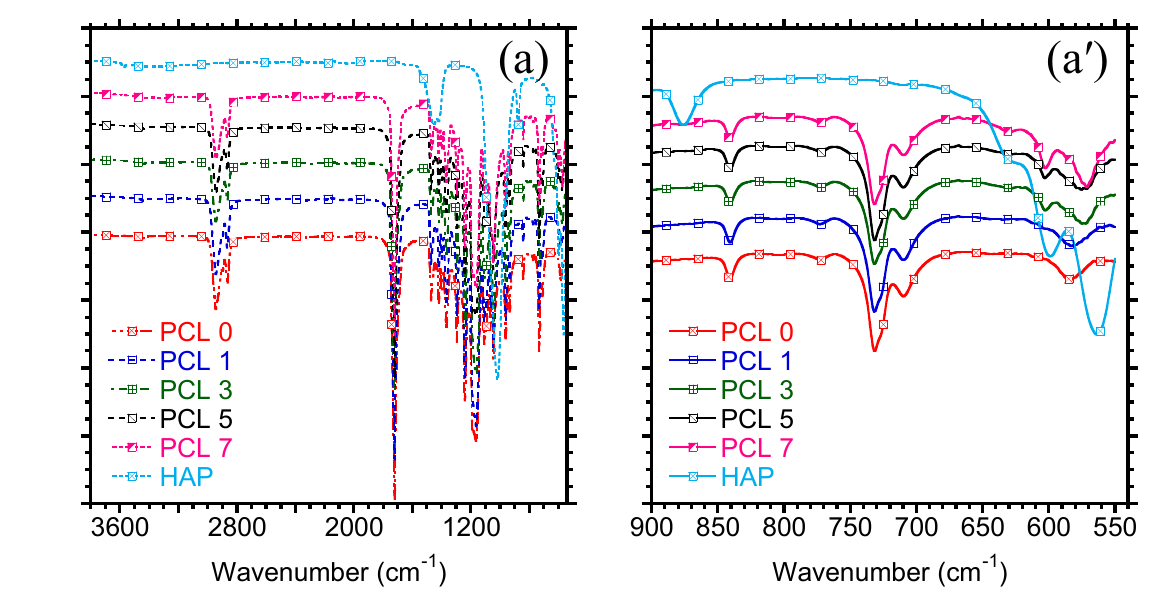
Figure 3. Chemical structures of ( a ) HAP, PCL, and PCL/HAP composites. ( a’ ) zoomed region at low wavenumber (550–900 cm -1 ).